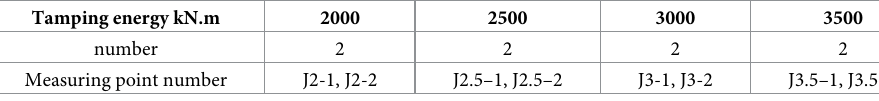
Table 1. Measuring points for the static loading tests with different tamping energy. Tamping energy kN.m